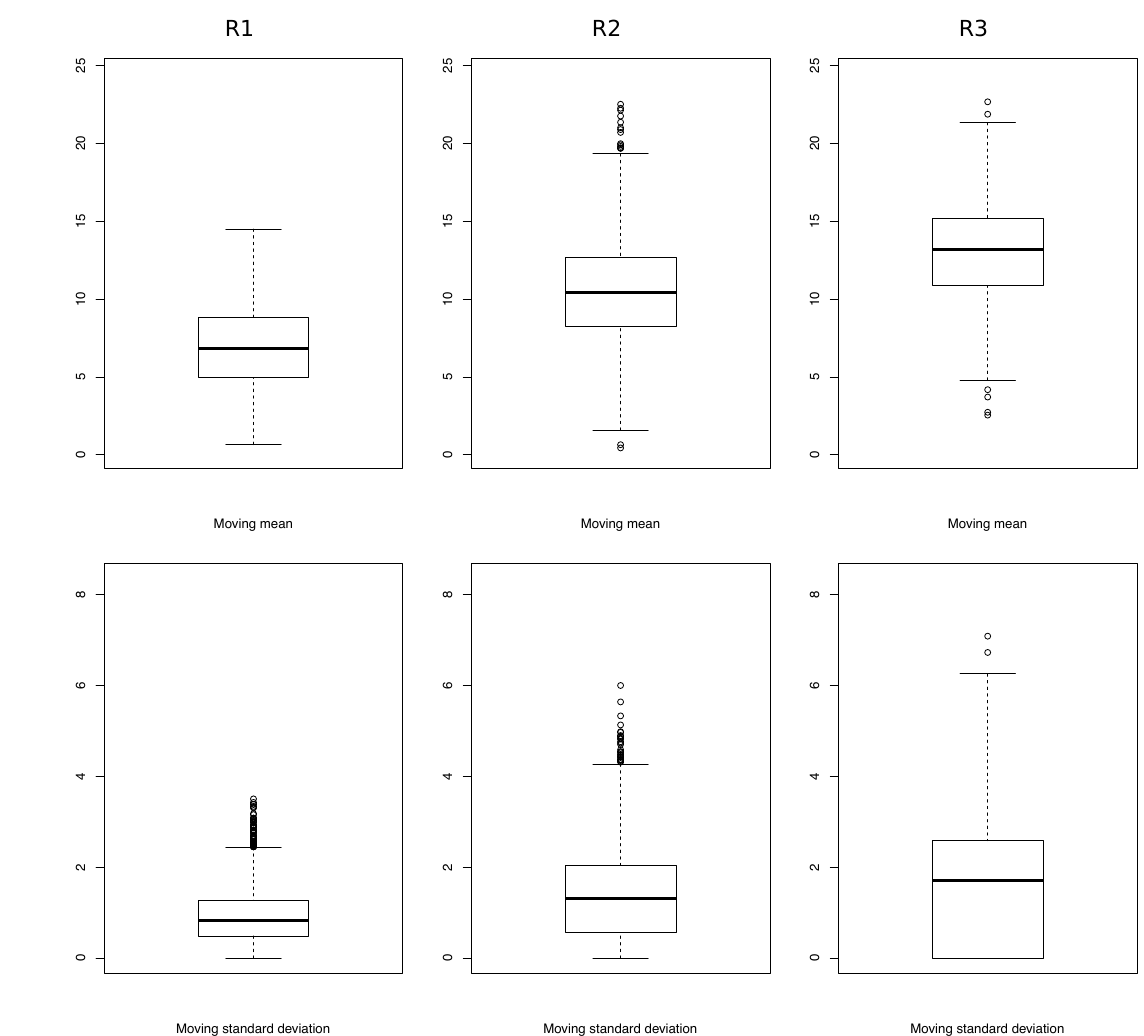
Figure 4. Top panel: moving mean of wind speed computed on 2-day intervals (nine time steps) for each regime of the H-MS-VAR model fitted at site 10. Bottom panel: same for moving standard